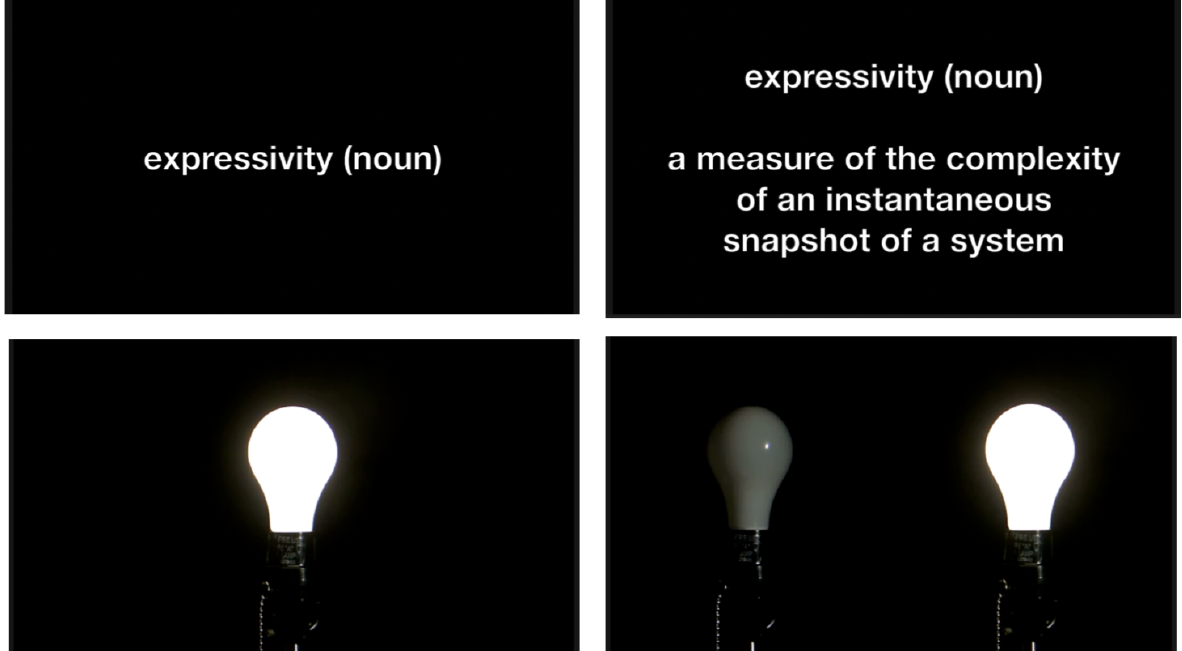
Figure 4: Images and the script for the concrete video experience in step two of the experiment. This instructional video solidified the